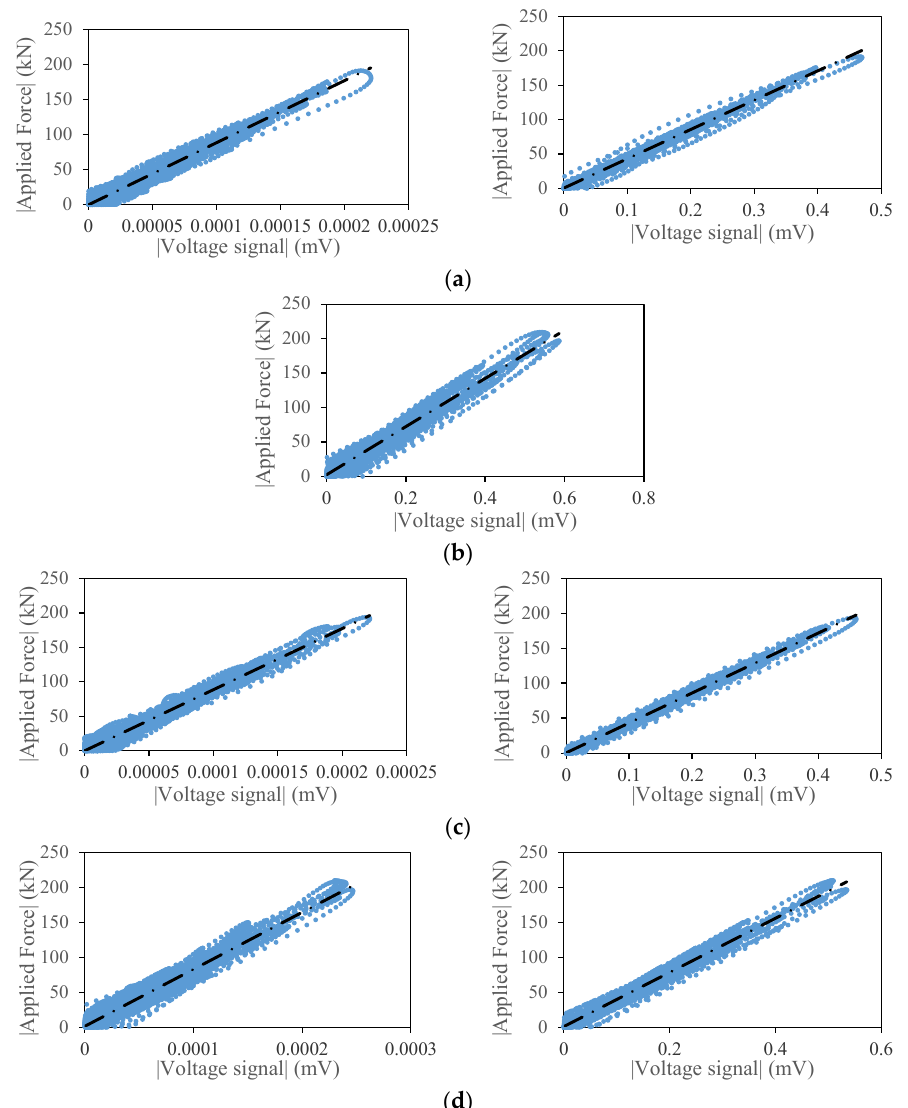
Figure 13. Regression graphs of normalized force from specimens and normalized signal from sensors. ( a ) FF-15S-II (Sensor 3 and Sensor 4); ( b ) FF-15S-IV (Sensor 4); ( c ) FSF-15S-II (Sensor 3 and Sensor 4); ( d ) SF-30S-III (Sensor 3 and Sensor 4). Table 7. Ratio between maximum force applied to a specimen and maximum voltage signal of Sensor 4.